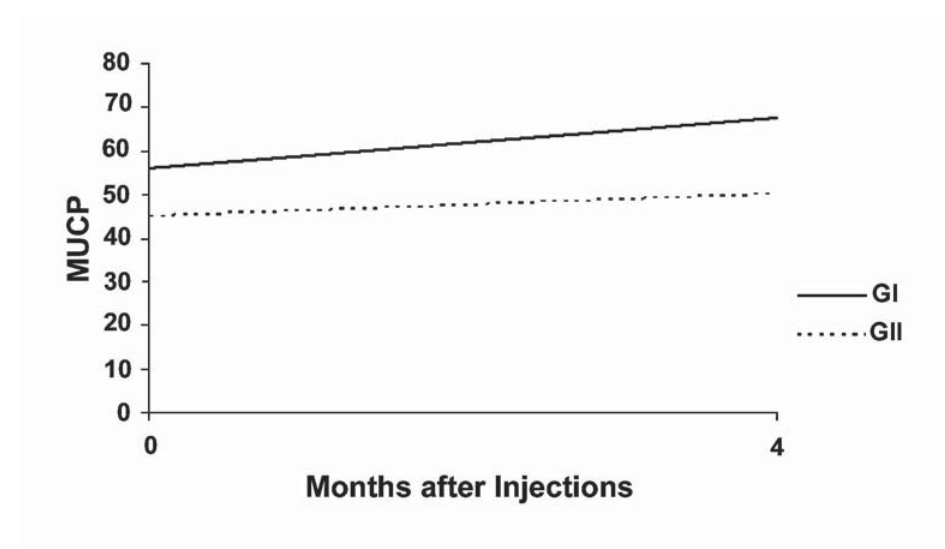
Figure 4 – Behavior of maximum urethral closure pressure (MUCP) before and after treatment with periurethral injection.GI: